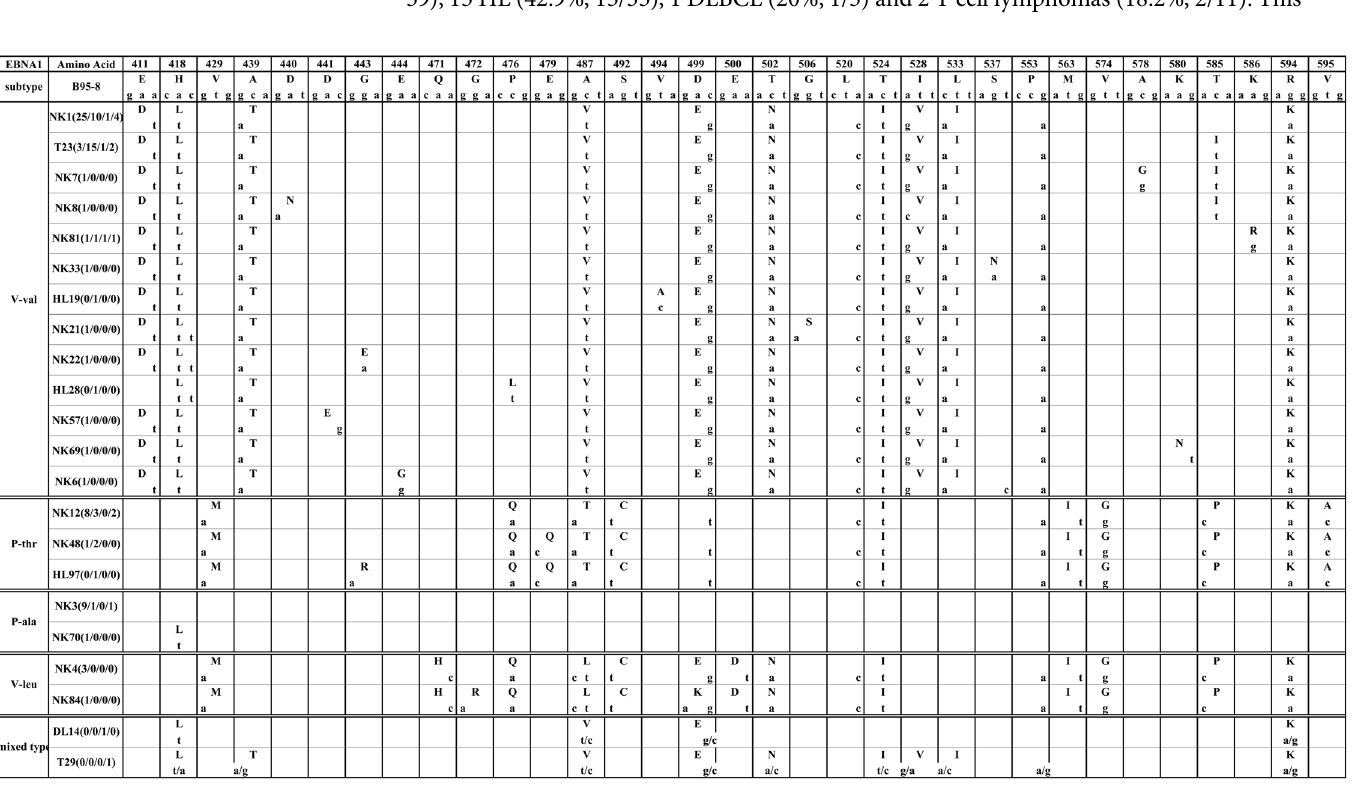
(CTA ! CTC) and 553 (CCG ! CCA). In this group, partial isolates showed one or more addi- tional changes except for the consensus sequence changes. There were 23 isolates (representative by T23) with a remarkable substitution at residue 585 (Thr ! Ile), appearing in 5 NK/T (8.5%, 5/